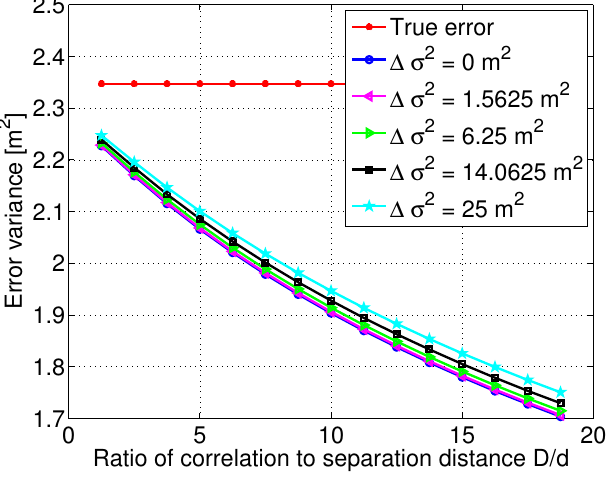
Figure 8. Estimation error variance corresponding to a single Gauss-Markov process and different ∆ σ 2 modeling